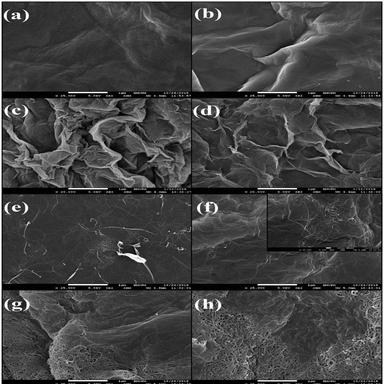
FESEM images of (a) GO, (b) rGO, (c) PPy/GO, (d) PPy/rGO, (e) MWCNT/GO/NCC (f) MWCNT/rGO/NCC, (g) PGMGN and (h) r-PGMGN.